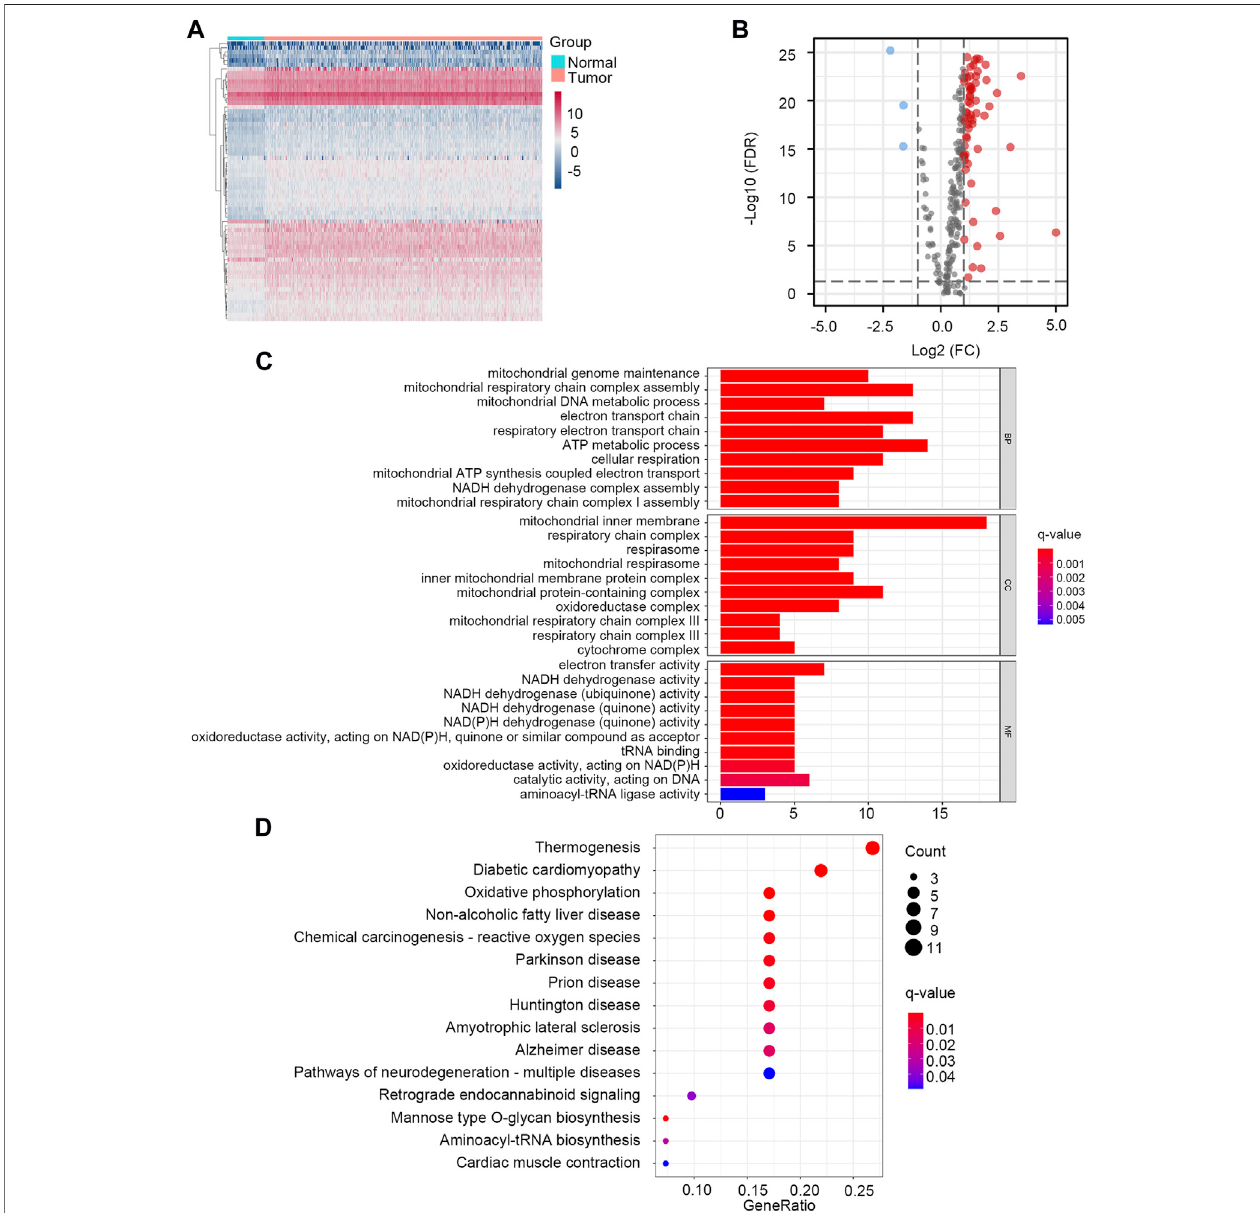
FIGURE1| Identi fi cationandenrichmentanalysisofLMRGsinHCC. (A) TheheatmapshowedtheexpressionlevelofLMRGsineachsample. (B) Thevolcanoplot displayed down-regulated and up-regulated LMRGs. (C) GO enrichment analysis. (D) KEGG pathway enrichment analysis.